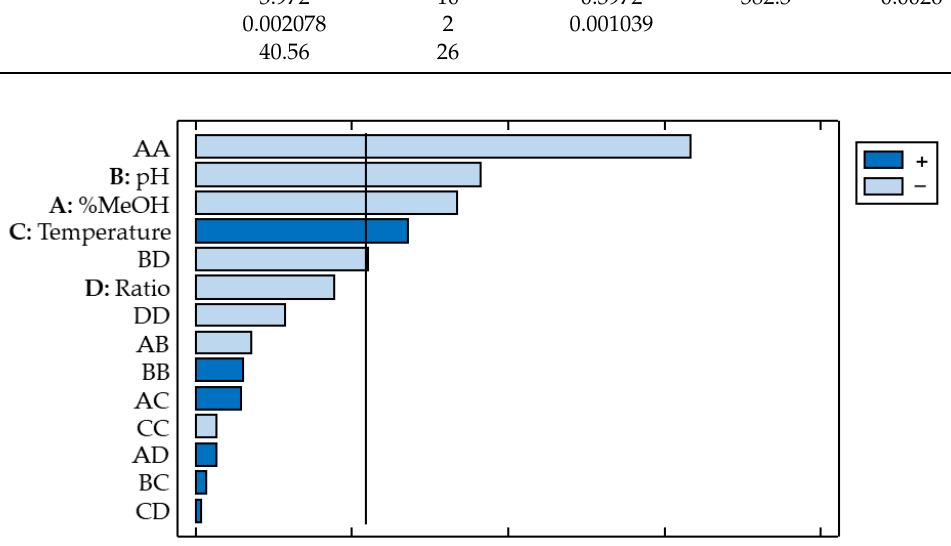
Figure 5. Pareto chart of the response variable antioxidant activity (Y DPPH